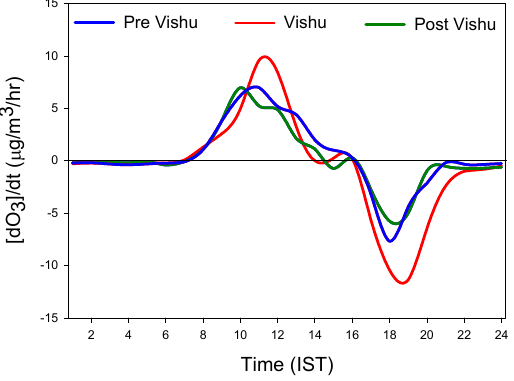
Figure 8. Rate of change of O 3 on Vishu and control days.